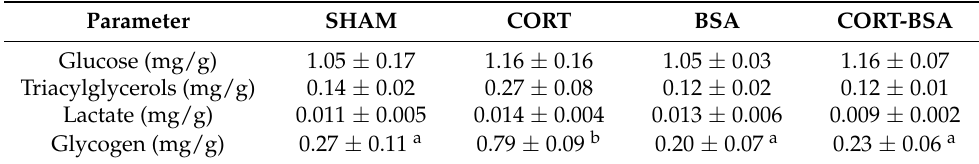
Table 2. Hepatic glucose, triacylglycerols, lactate and glycogen content in vehicle (sham-control), cortisol, BSA and cortisol-BSA administered fish at 72 h post-treatment. Results are expressed as mean ± SEM ( n = 8). Different letters indicate significant differences between groups ( p value < 0.05). All data were analyzed using one-way ANOVA and Tukey’s HSD as a post hoc test. Parameter